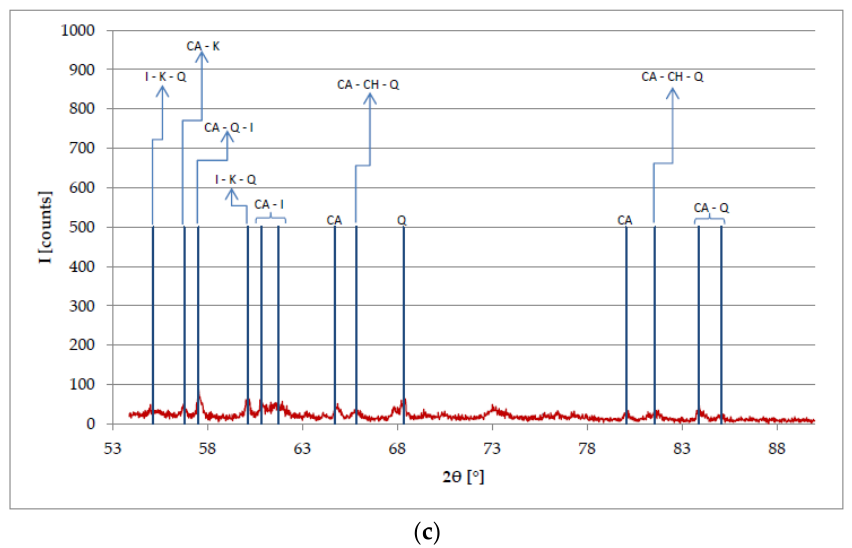
Figure 3. Attribution of the identified mineral phases in Table 3 to peaks of the TQ0 diffractogram: ( a ) 2θ is 5°–33°; ( b ) 2θ is 33°–53°; ( c ) 2θ is 53°–90°.